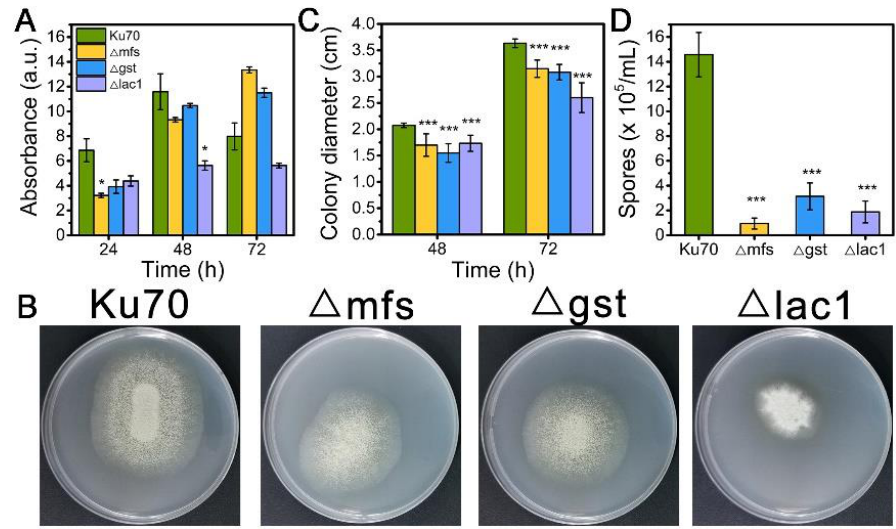
Figure 3. ( A ) The growth, ( B ) plate growth pictures, ( C ) colony diameters, and ( D ) sporulation of T. reesei Ku70, ∆ mfs, ∆ gst, and ∆ lac1 grown on TMM with 2% lactose. Both the spore assay and the plate growth pictures were performed at 72 h. Values are the means of three biological replicates, and error bars are the standard deviations of these three replicates. Asterisks indicate significant differences (* p < 0.05, and *** p < 0.001) as assessed by the Student’s t test.